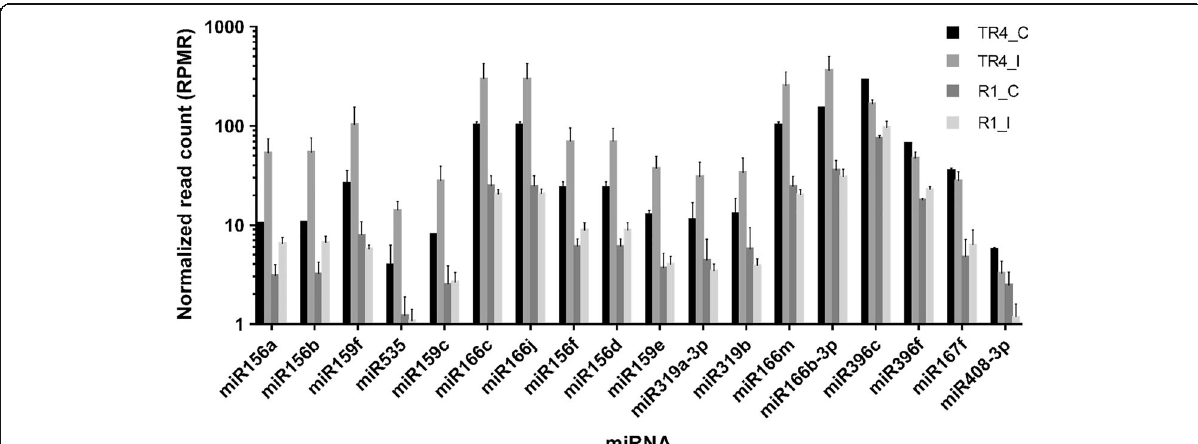
Fig. 3 Expression of miRNAs in each treatment group. Members of miR156, miR159 and miR166 families showed increased expression in TR4_I as compared to TR4_C. Not as much increase was induced by R1 inoculation. The normalized read count on the Y-axis was calculated as “ reads per million reads ” for each sRNA library. The logarithmic scale was used to display the normalized read count. Error Bars represent Standard Error of the Mean (SEM)